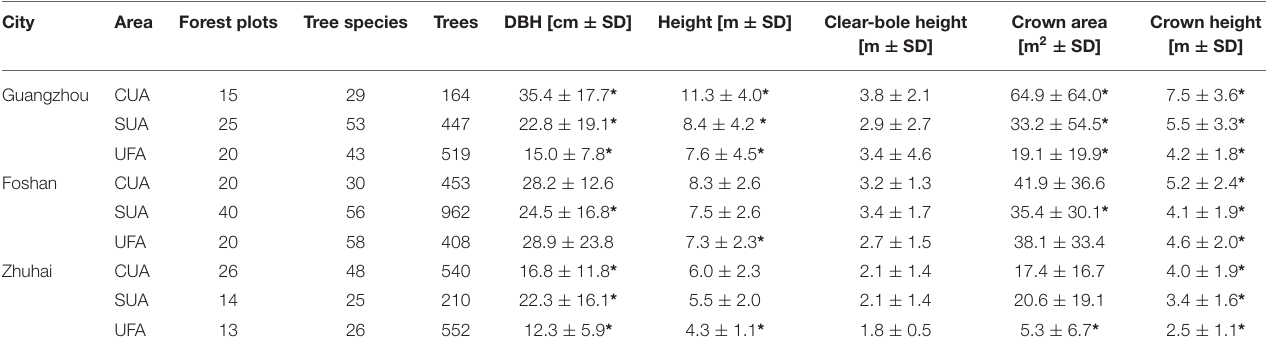
TABLE 3 | The characteristics of the surveyed trees in CUA, SUA and UFA of Guangzhou, Foshan, and Zhuhai, including numbers of forest plots, numbers of tree species, numbers of trees, DBH (cm